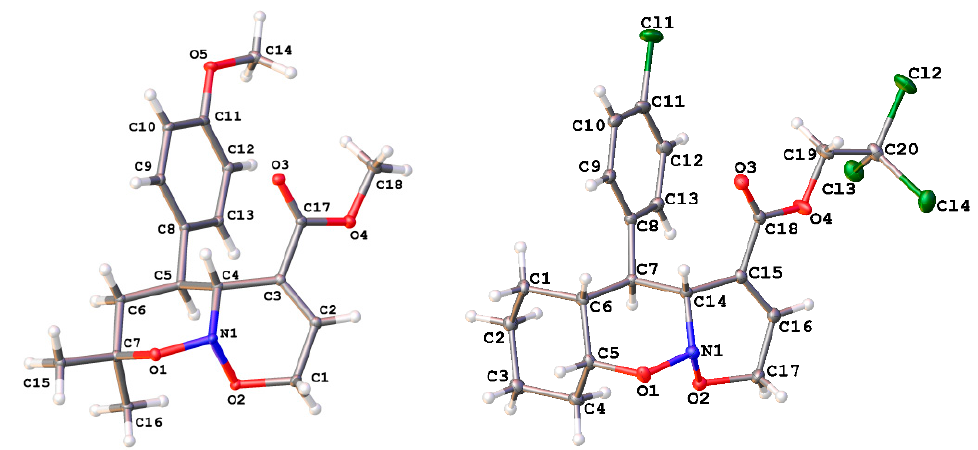
Figure 1. General view of the compounds 3b (left) and 3p (right) in the representation of non-hydrogen atoms as thermal ellipsoids at a 30% probability level.